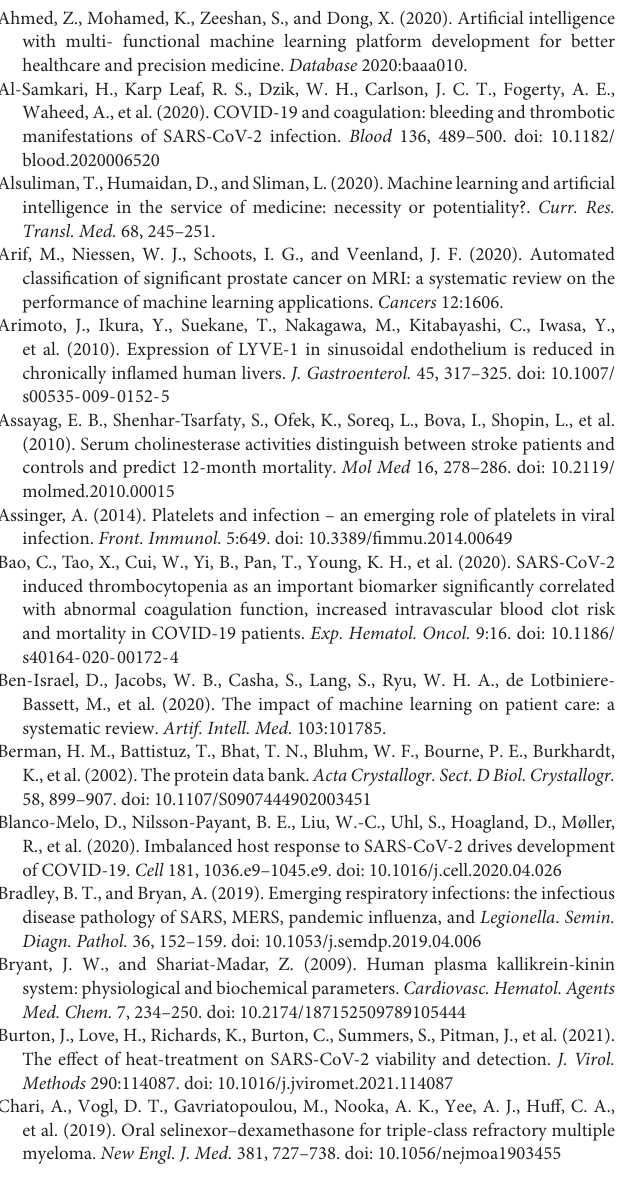
Supplementary Table 2 | Clinical information of COVID-19 patients. Supplementary Table 3 | List of DEPs altered in COVID-19 positive vs. negative. Supplementary Table 4 | List of DEPs altered in COVID-19 severe vs. non-severe. Supplementary Table 5 | Consolidated sheet of machine learning output file.